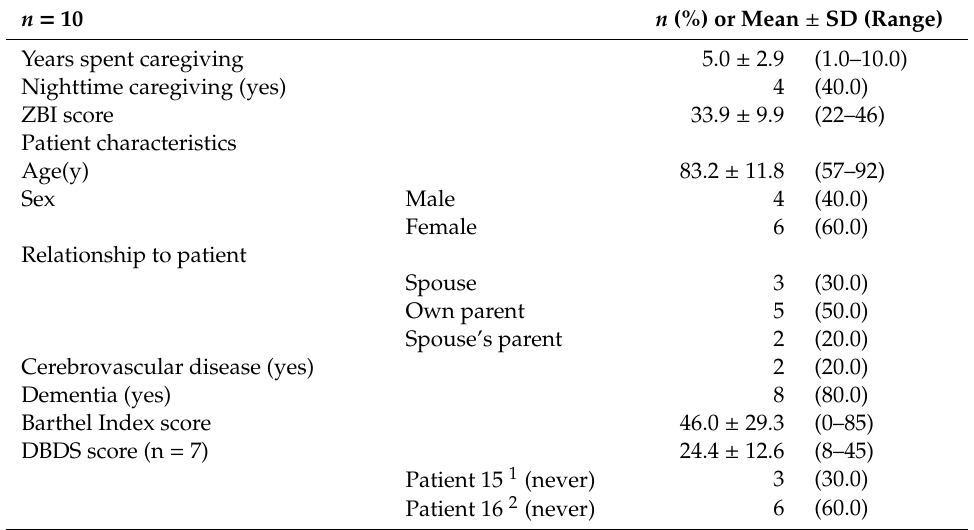
Table 1. Care status